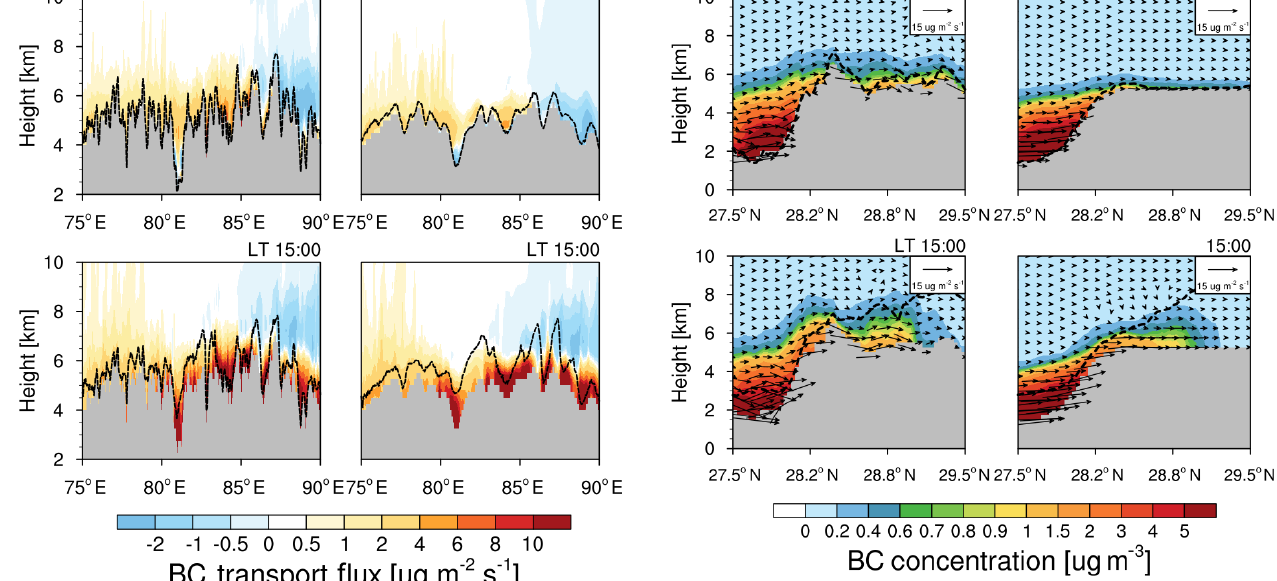
Figure 9. Longitude–height cross section of BC transport flux along the cross line (shown as the black dashed line in Fig. 3) from the simulations with the complex and smooth topographies at 03:00 and 15:00 local time (LT) averaged for 1–20 April. The PBL height along the cross section is shown here as the black dashed line.